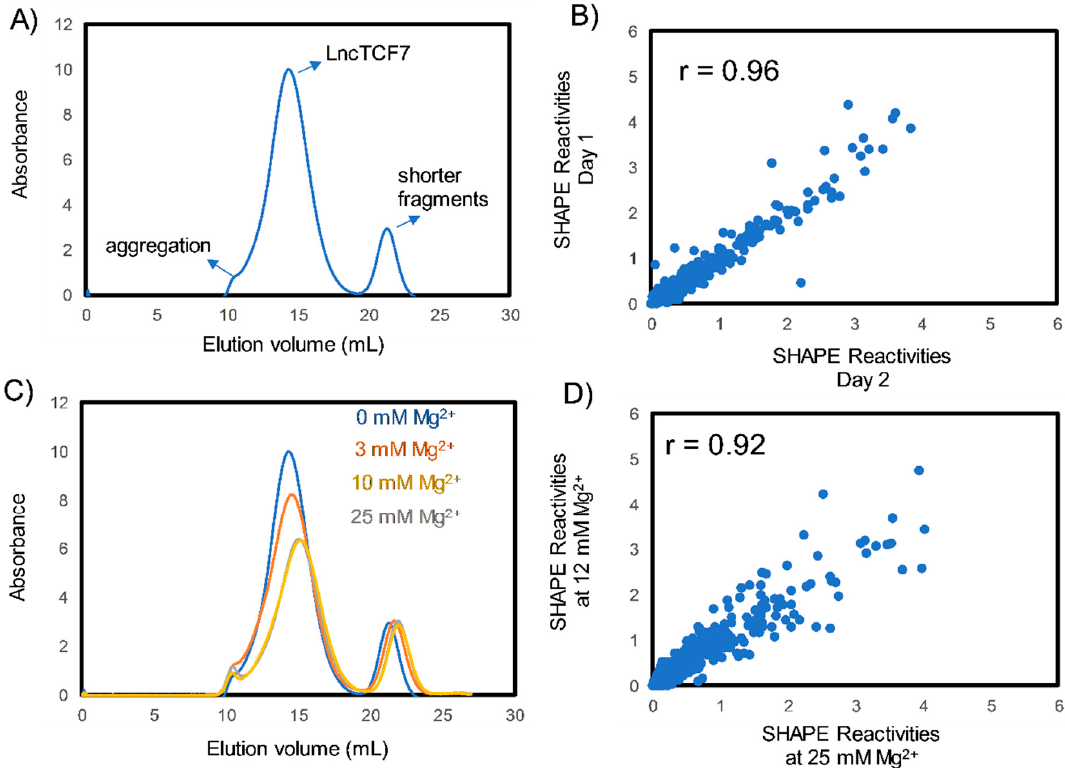
Figure 1. Purification and folding of the lncRNA lncTCF7. ( A ) Size exclusion chromatography (SEC) profile of lncTCF7 purified using native purification. ( B ) Representative scatter plot comparing SHAPE (selective 2 ′ -hydroxyl acylation analyzed by primer extension) reactivities from two independent SHAPE-MaP experiments. Our purification method is reproducible, as indicated by a high correlation coefficient ( r = 0.96). Experiments were performed in triplicate; correlations were similar between all three replicates. ( C ) SEC profiles of lncTCF7 purified and folded at varying [Mg 2 + ]. LncTCF7 can be purified to homogeneity over a broad range of [Mg 2 + ]. ( D ) Scatter plot comparing SHAPE reactivities of lncTCF7 folded at 12 mM and 25 mM Mg 2 + (reactivities represent average of three independent trials). The high correlation ( > 0.9) between SHAPE reactivities of RNA folded at 12 mM and 25 mM Mg 2 + indicate that there are no significant structural changes beyond 12 mM [Mg 2 + ].